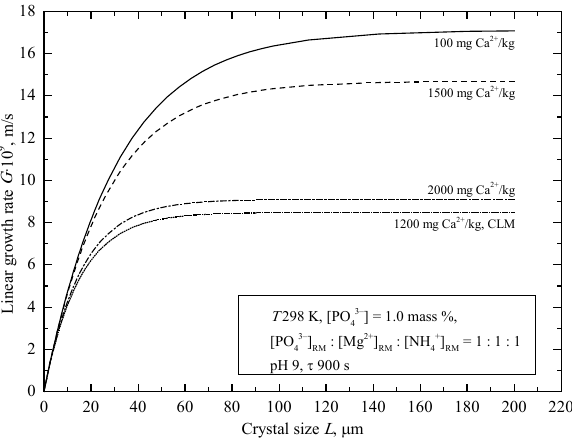
Figure 3: Size–dependent linear growth rate dependency courses observed in struvite crystals obtained for various calcium ions concentrations in a feed solution, as well as from real cattle liquid manure CLM [24] (RE SDG MSMPR kinetic model, (Eq. (7) in Table 2 with model parameters values presented in Table